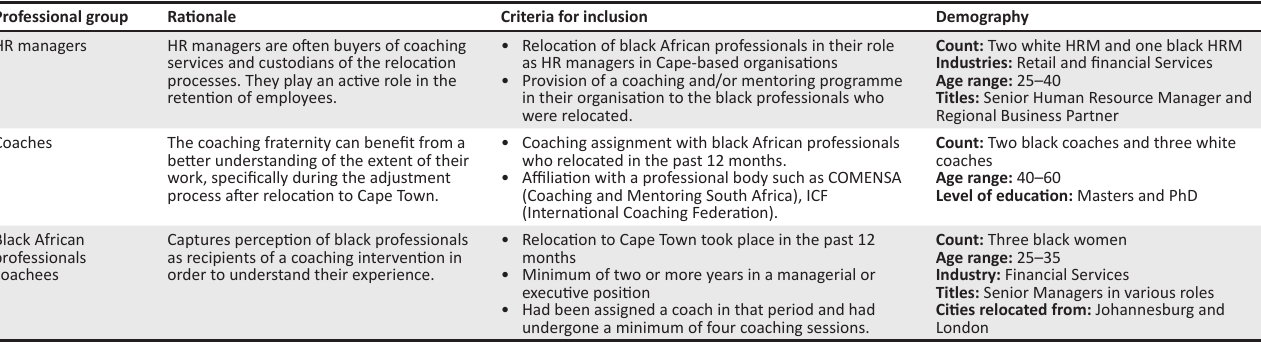
TABLE 1: Rationale, inclusion criteria and demography for participants. Professional